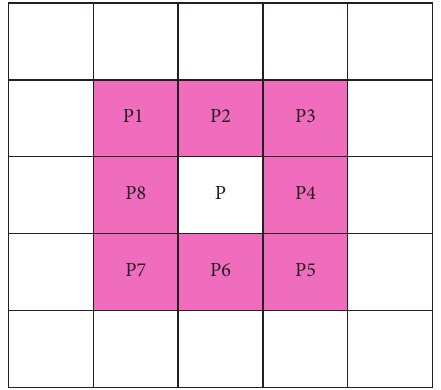
Figure 4: The eight neighbors of the pixels within an